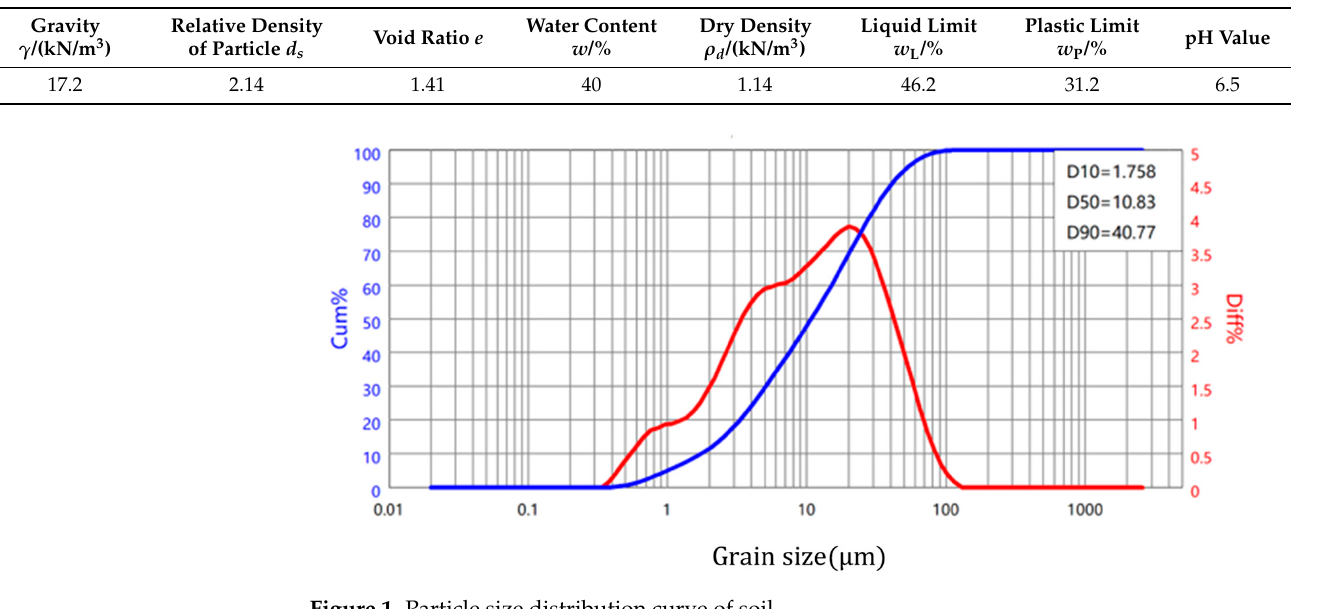
Table 2. Basic physical and mechanical properties of soil.